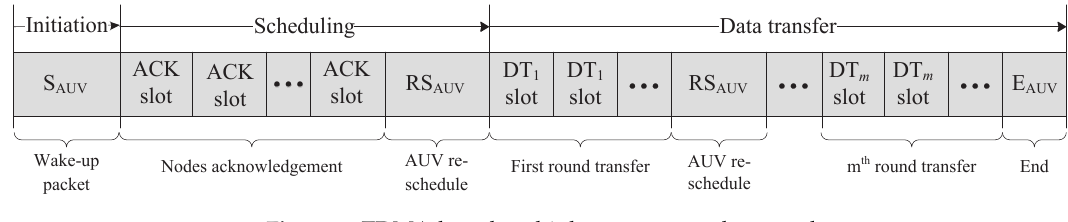
Figure 5. TDMA-based multiple access control